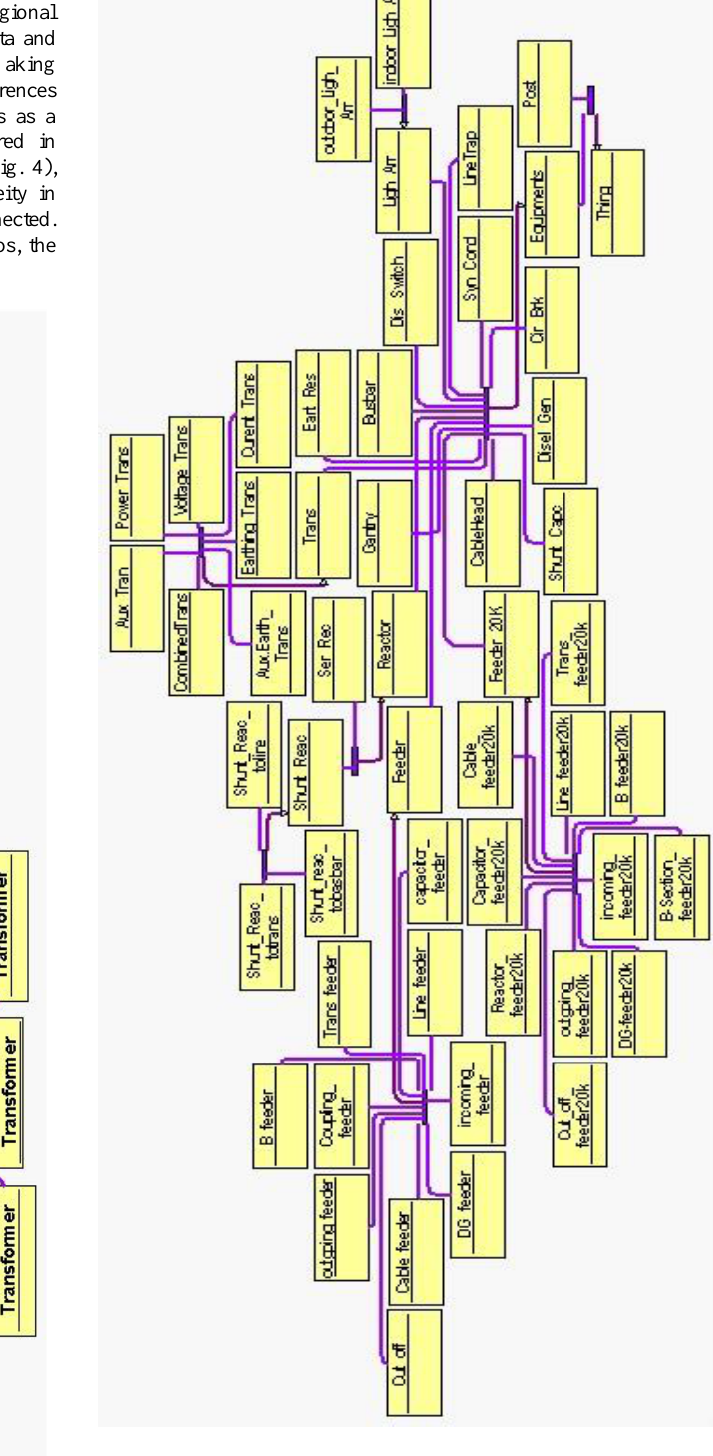
Figure 4. Ontology used for Database